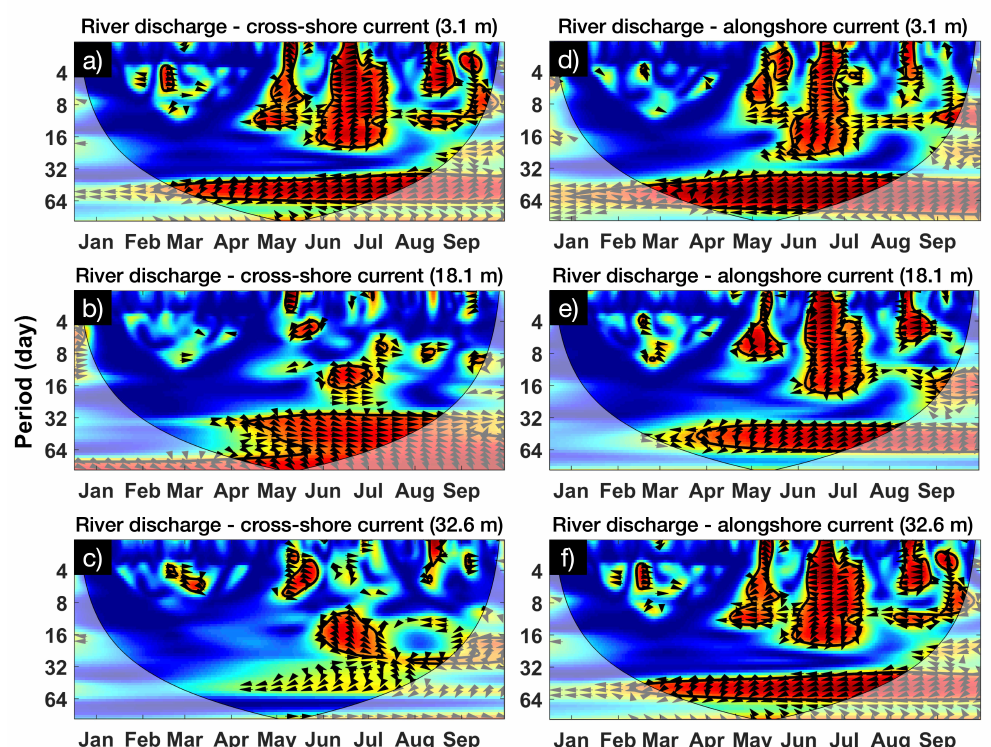
Figure 5. Coherence between time series of river discharge and currents (January–September 2009) at three depth levels (3.1 m, 18.1 m and 32.6 m). ( a – c ) Cross-shore and ( d – f ) alongshore current compo- nents. Statistically significant (95% confidence level) values are shown in red and are highlighted with black lines. Blue colors indicate areas of low spectral coherence. Shaded areas denote the cone of influence of the wavelet computations. In all panels, black arrows indicate the phase between the wind and current time series. The time series are in phase when the arrows point to the right (90°), and out phase when pointing to the left